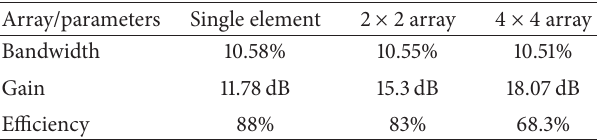
Table 4: Simulated results of single element and 2 × 2 and 4 × 4